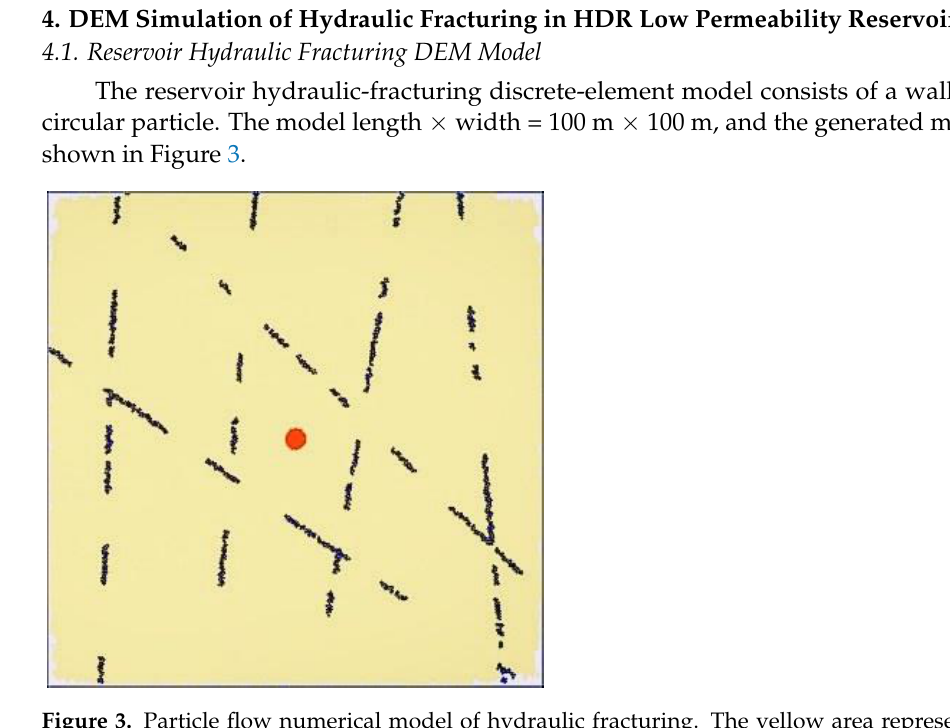
Table 1. Reservoir particles micromechanics parameters.